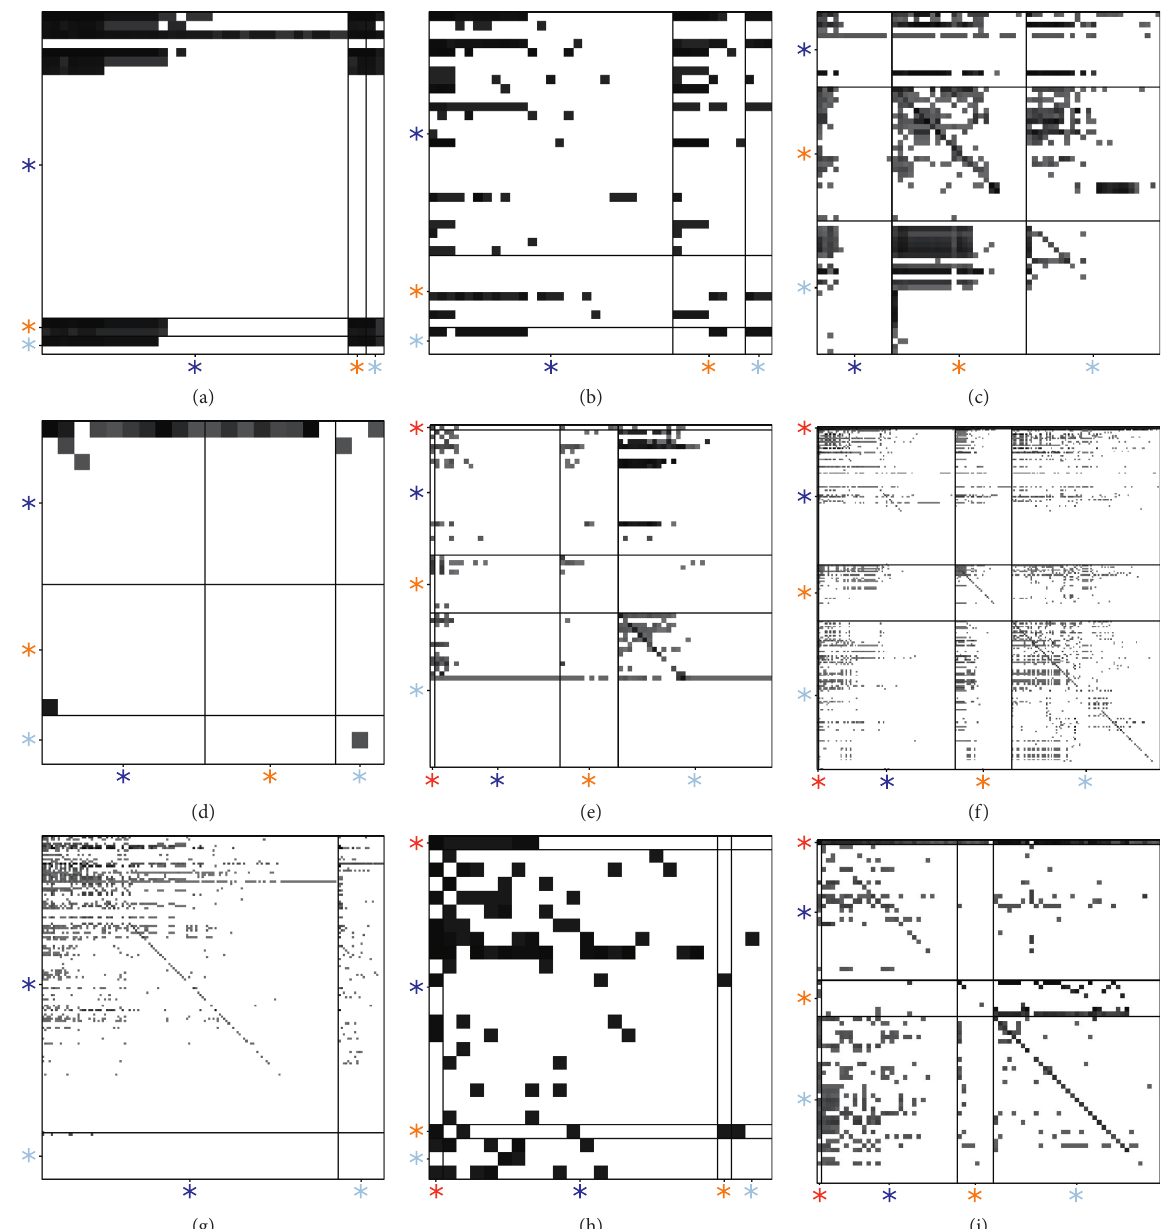
Figure 3: Adjacency matrices of functional communication networks from select enterprises. Color intensity indicates the log value of the weighted number of edges. Horizontal and vertical lines divide matrices into labeled, role-specific sections (red is for an executive, dark blue is for a manager, orange is for a supervisor, and light blue is for an operator). Diagonal squares are areas of intrarole communication, and others are areas of interrole communication. Adjacency matrices are sparse and distinguished by their streaking horizontal lines. Other enterprises are shown in Section